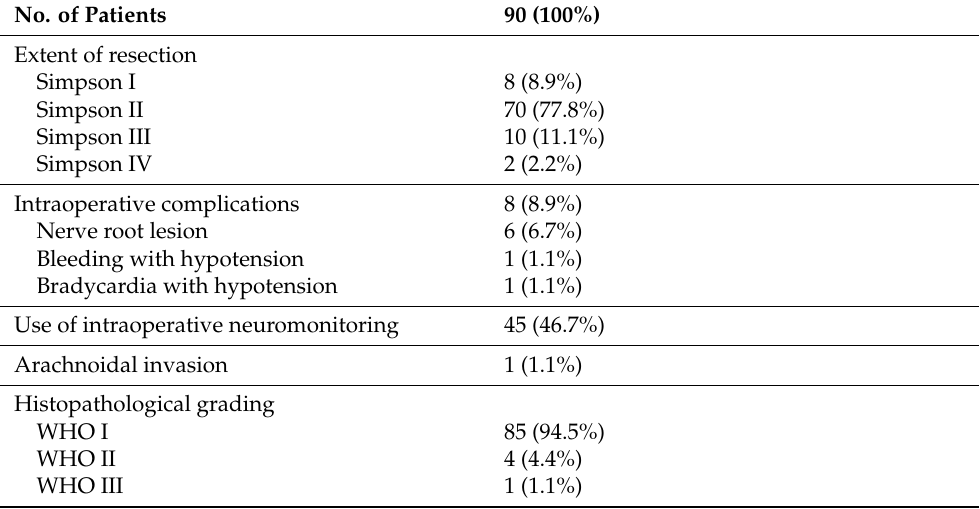
Table 3. Intraoperative findings of the patient cohort.